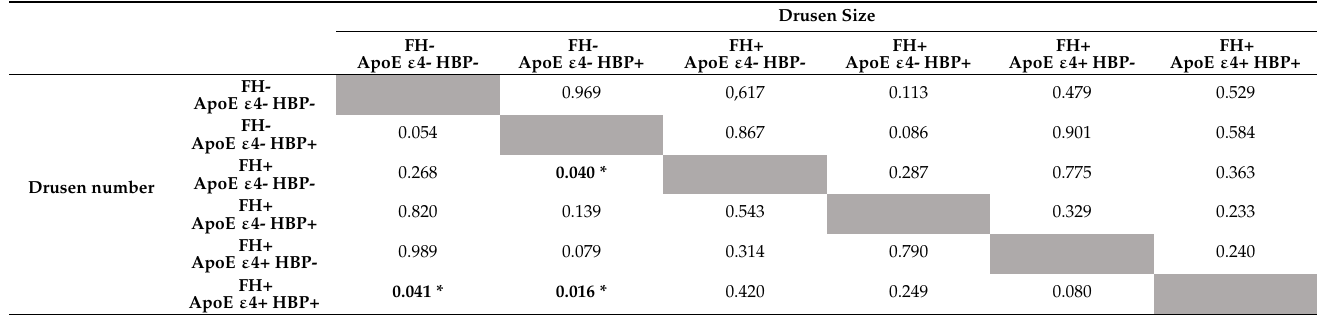
Table 7. p -value of the number of drusen between the study groups according to FH, ApoE ε 4- or ApoE ε 4+ genotype, and HBP. Mann Whitney U